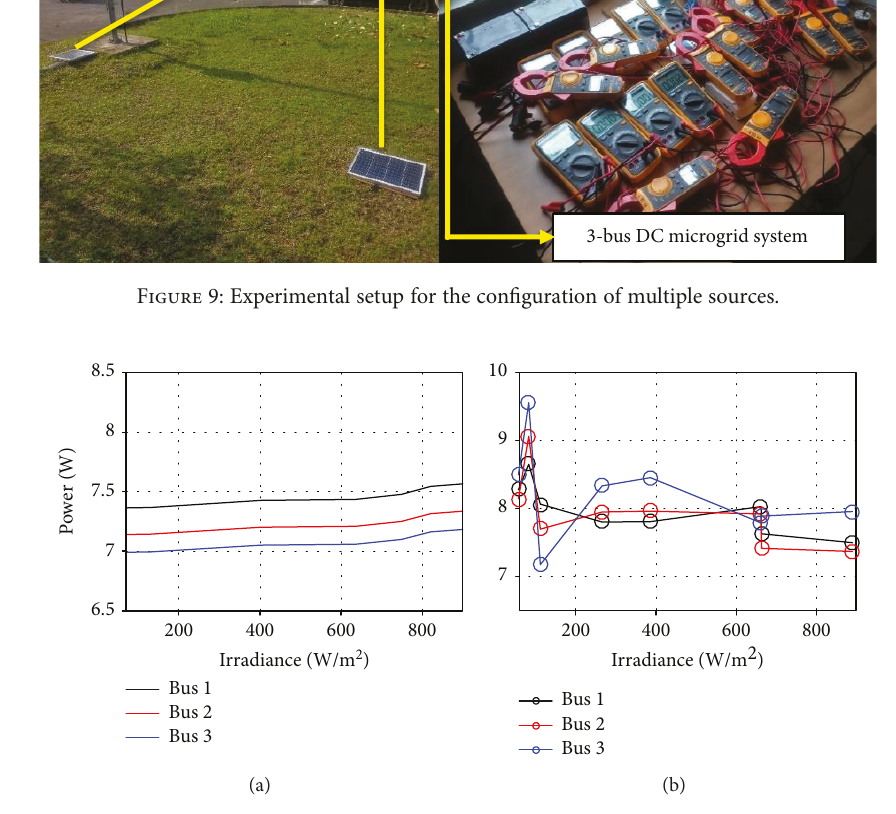
Figure 10: Power absorption at various radiation levels for (a) single source and (b) multiple